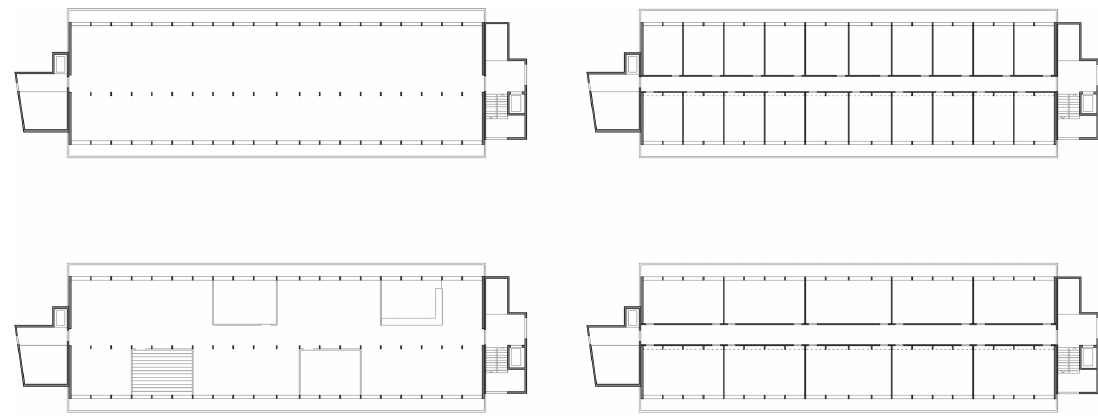
Figure 3. Different possible organisations of the ground plan with the Working Space system.